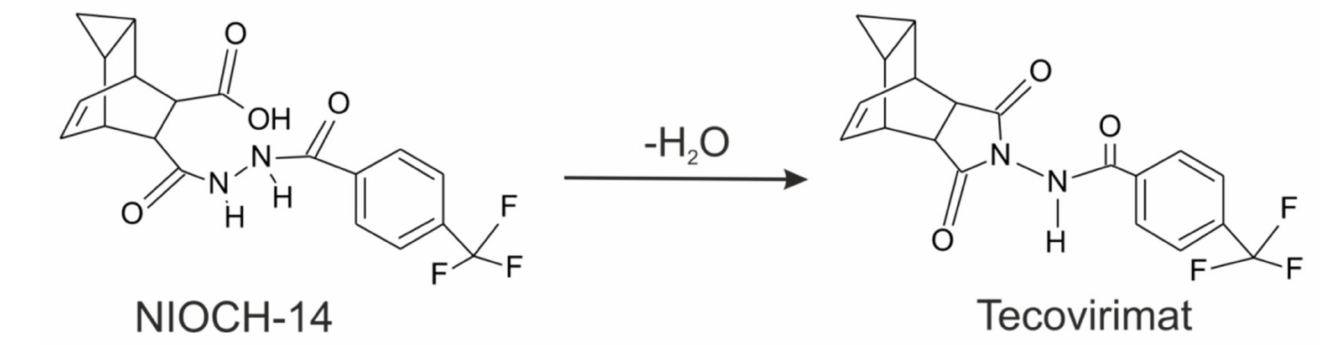
Figure 3. Metabolic conversion of NIOCH-14 into ST-246